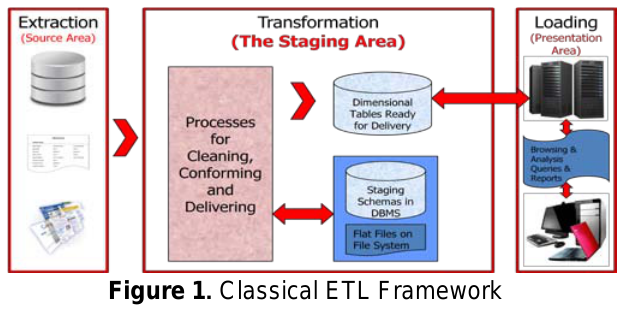
Figure 1 . Classical ETL Framework